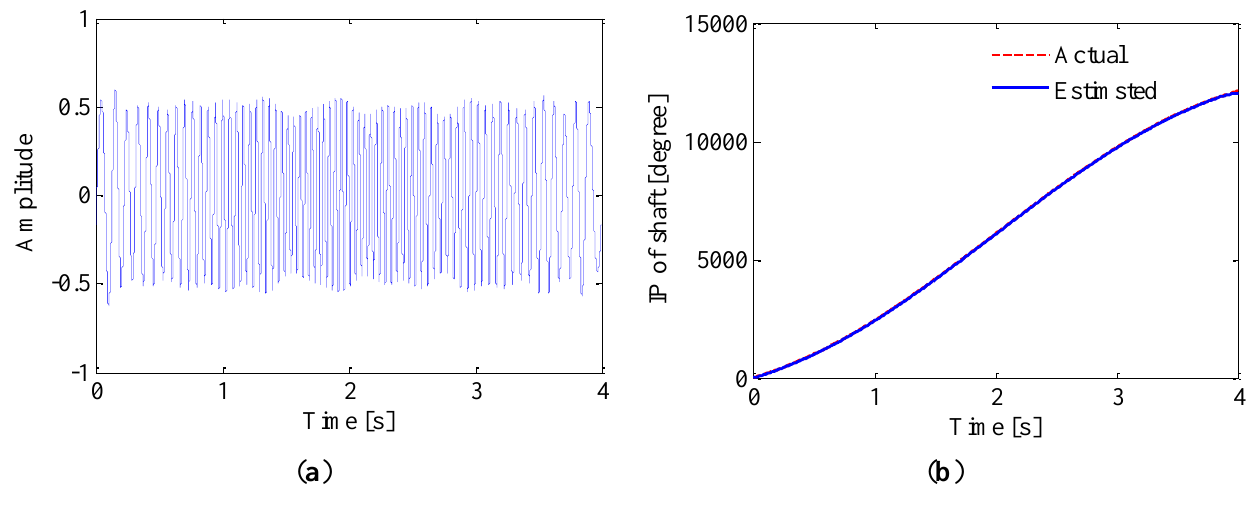
Figure 9. ( a ) Waveform of 2nd harmonic; ( b ) Instantaneous phase of shaft.